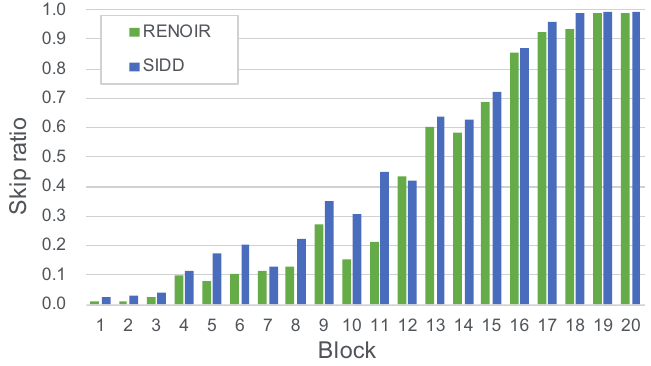
Figure 3. Skip ratio per block of the DRDN while testing on the RENOIR and the SIDD.